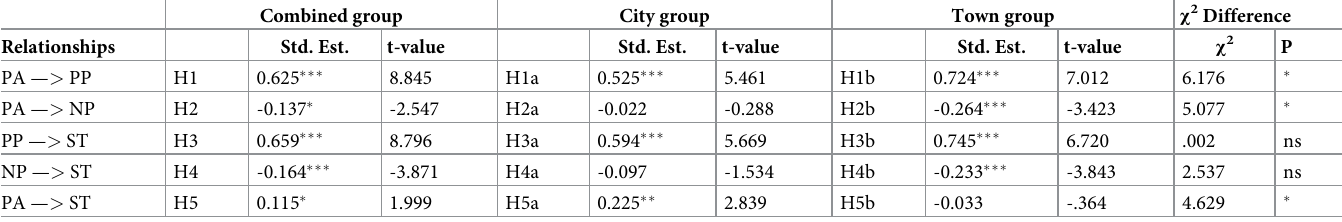
Table 8. Hypothesis testing of structural model. Combined